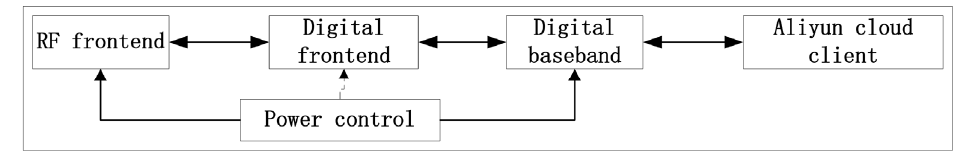
Figure 12. Ground station receiver design.